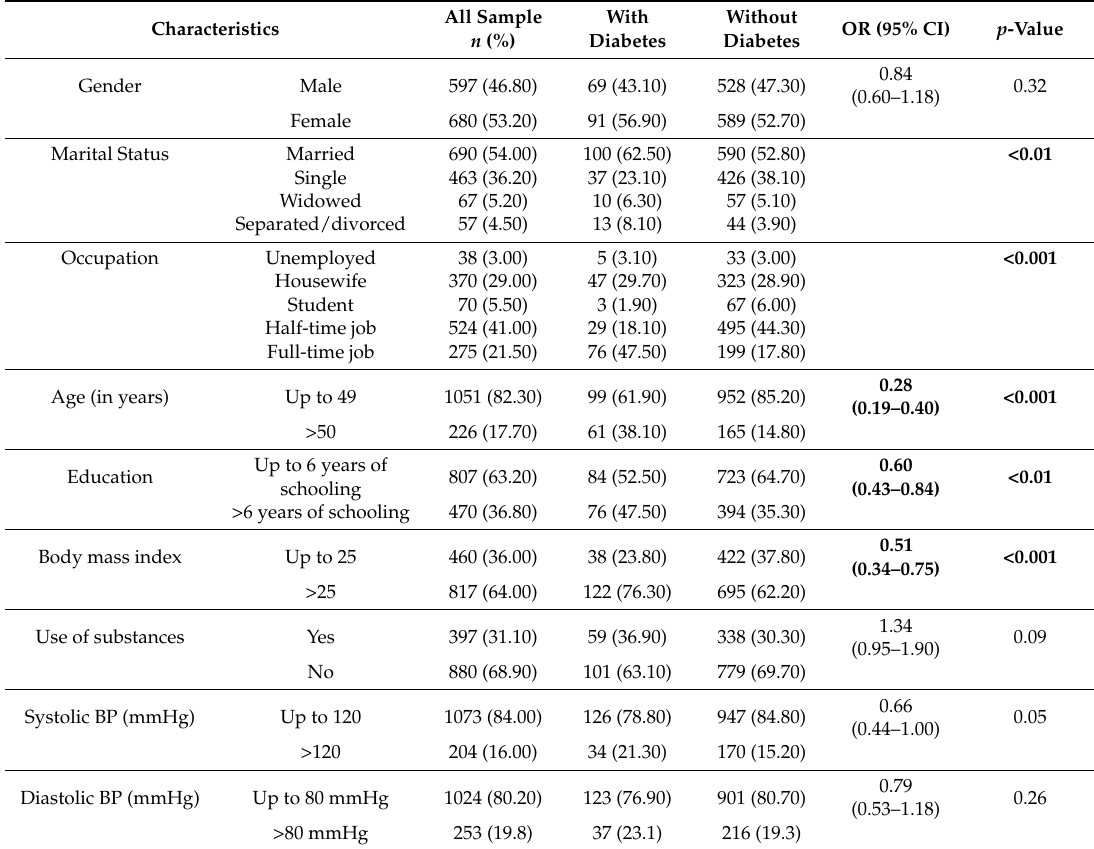
Table 1. Association between socio-demographic and clinical characteristics divided by type 2 diabetes of the populations in the